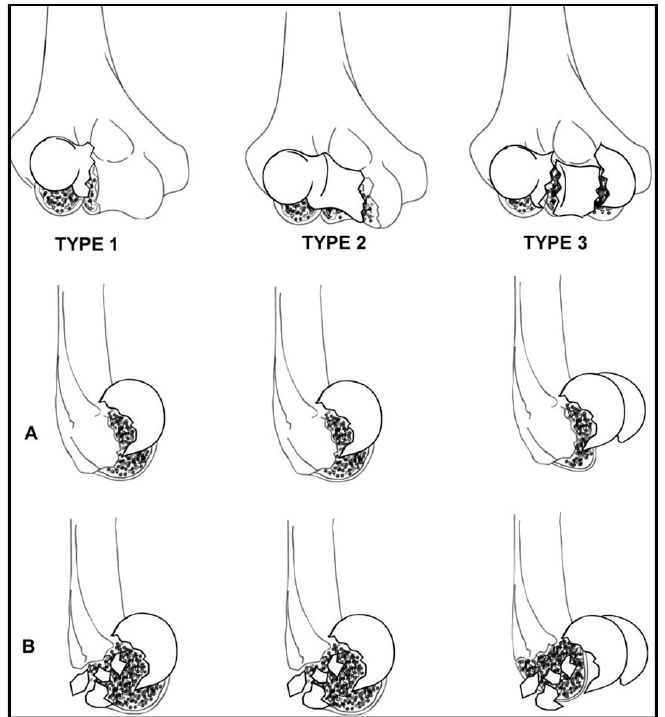
Figure 2. The Dubberley classification of capitellar and trochlear fractures. Subtype ( A ) fractures are not characterized by posterior comminution, while Subtype ( B ) show posterior comminution (From Dubberley J.H., Faber K.J. and Macdermid J.C. et al. Outcome after open reduction and internal fixation of capitellar and trochlear fractures. J Bone Joint Surg Am 2006; 88: 47 [6]; with permission).